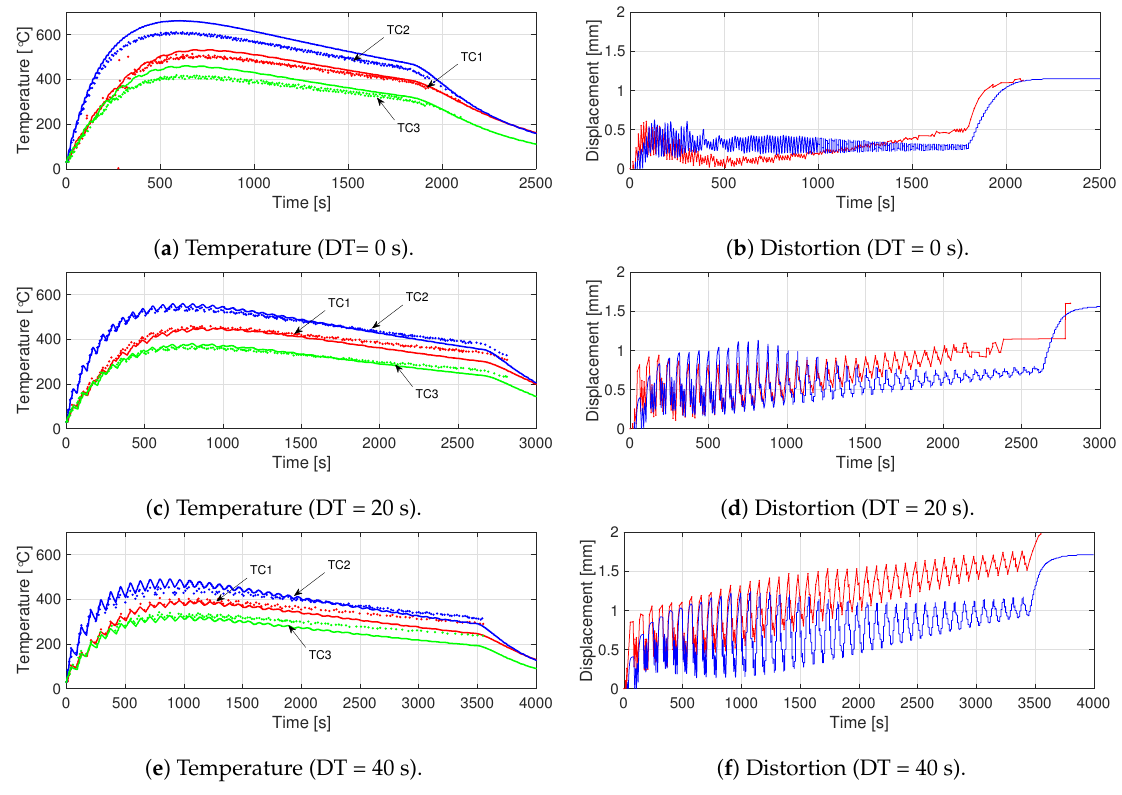
Figure 9. Comparison of Measurements and